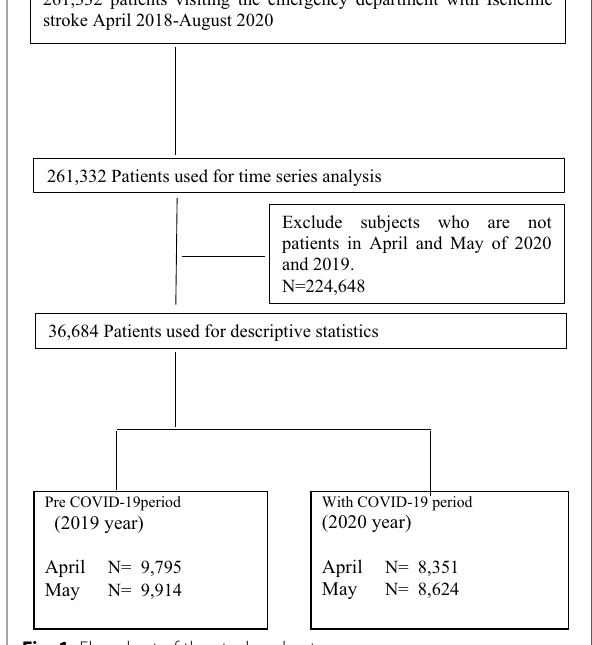
Fig. 1 Flowchart of the study